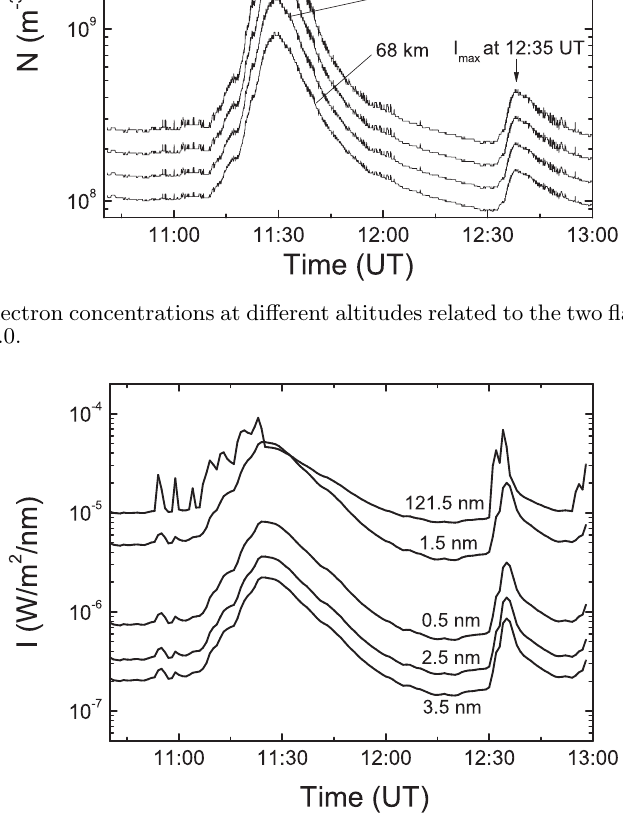
Fig. 3. Time distribution of the solar radiation intensity I which has the dominant role in perturbing the ionospheric